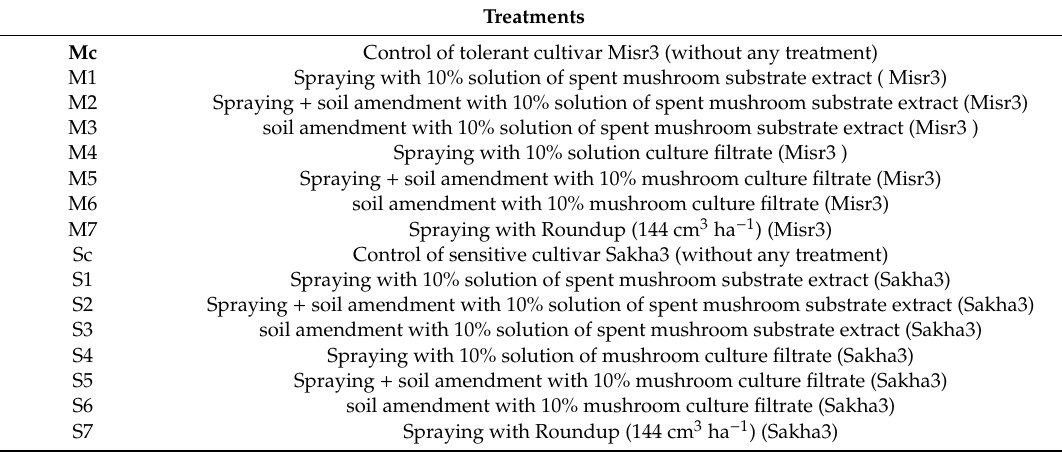
Table 10. Treatments of greenhouse experiments during the two